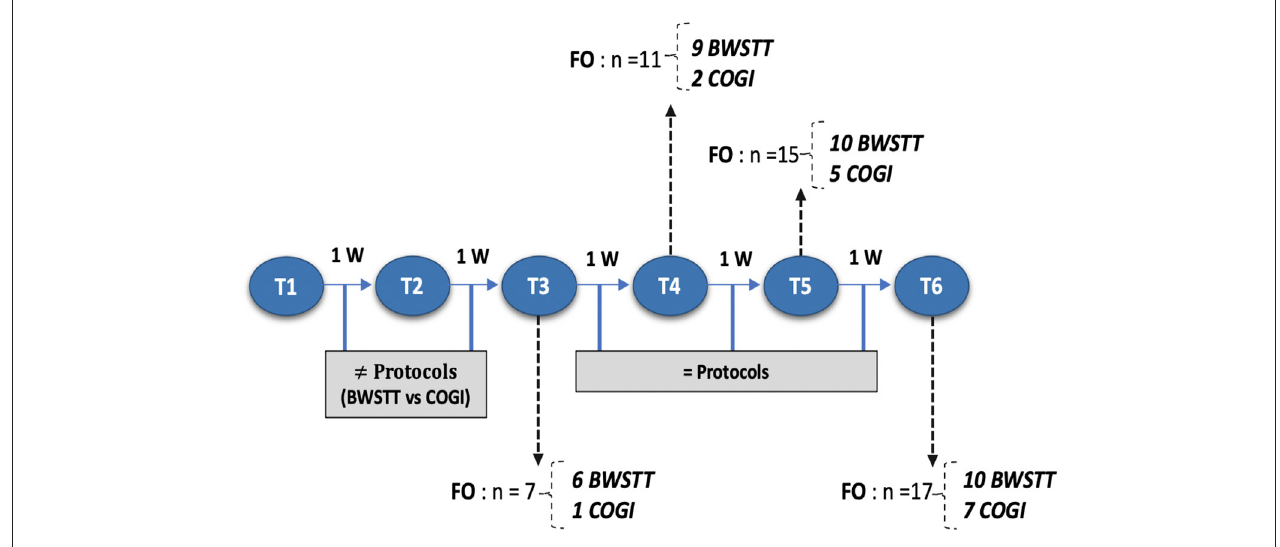
FIGURE 11 | Flow diagram describing each moment according to number of weeks and functional outcome recovery. FNR, Functional neurorehabilitation; UWTM, Underwater treadmill; T1, After 2 weeks, randomization time; T2, After 1 week of specify protocol; T3, After 2 weeks of specific protocol; T4, T5, T6, After 3,4, and 5 weeks of the same protocol; BWSTT,Body-weight supported treadmill training; COGI, conventional overground intervation; FO, Functional outcome.